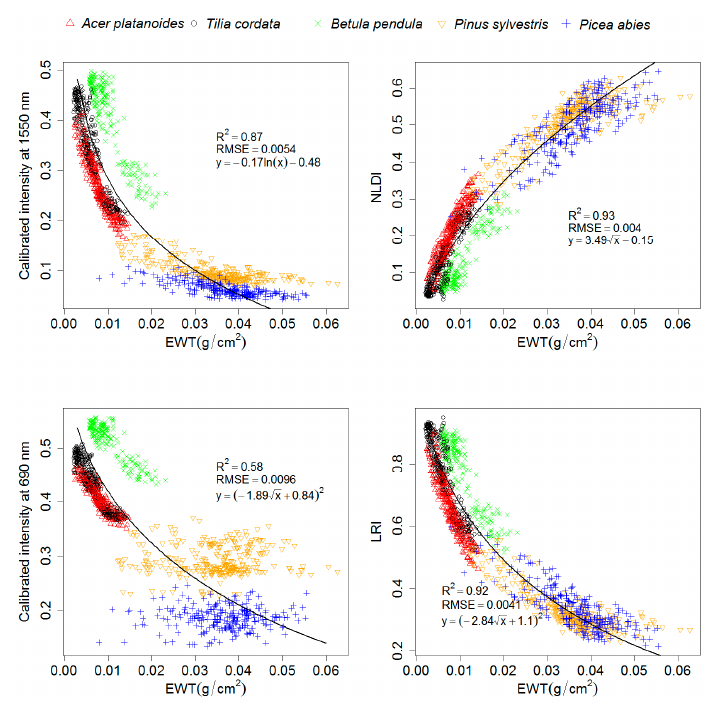
Figure 6. EWT plotted against spectral indices and the reflectance at the two wavelengths (1550 nm & 690 nm) for all measured species before the incidence angle correction ( n = 1180).